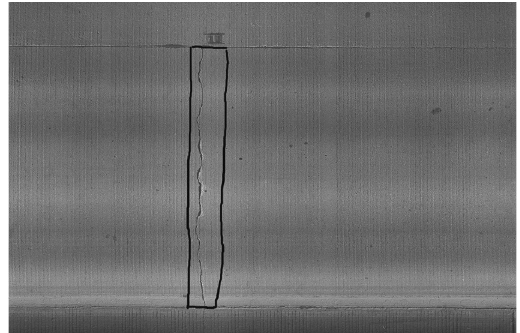
Figure 2. An example of transverse crack